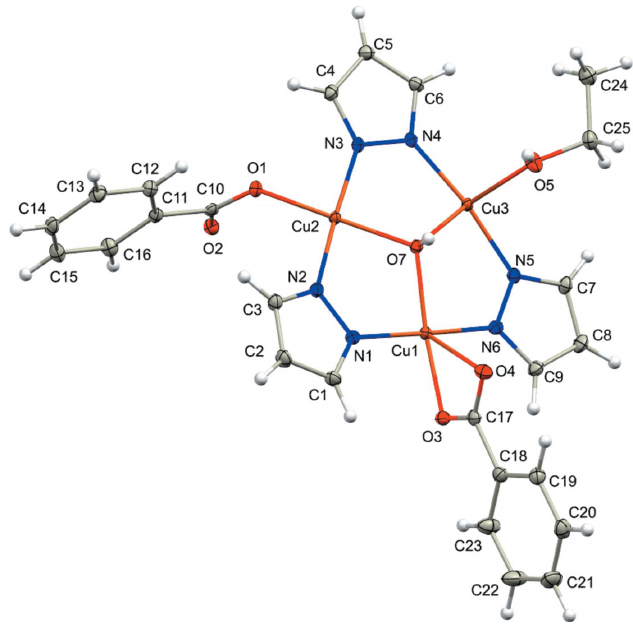
Figure 1 [Cu 3 ( (cid:2) 3 -OH)(pyz) 3 ] 2+ core of the title compound with displacement ellipsoids drawn at the 50% probability level. The H atoms and the solvent molecule are omitted for clarity.